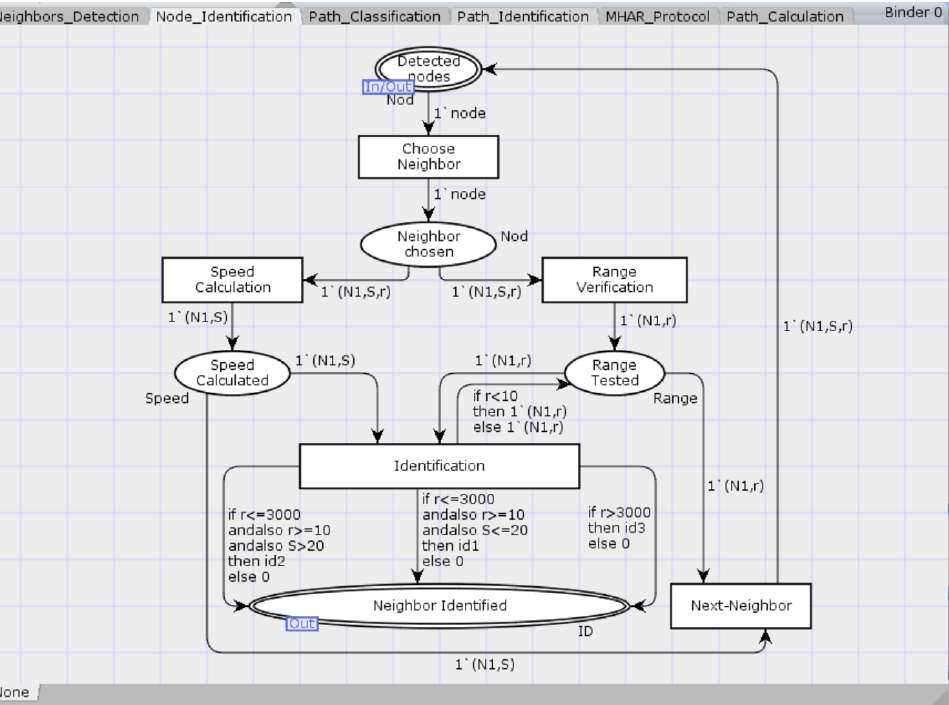
Figure 3. CPN modeling of node